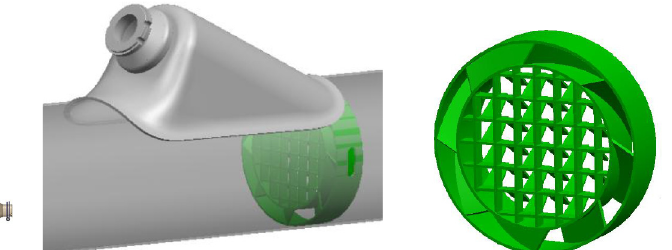
Fig. 2. A common after-treatment system layout on light trucks chassis. Fig. 3. New mixer with Special